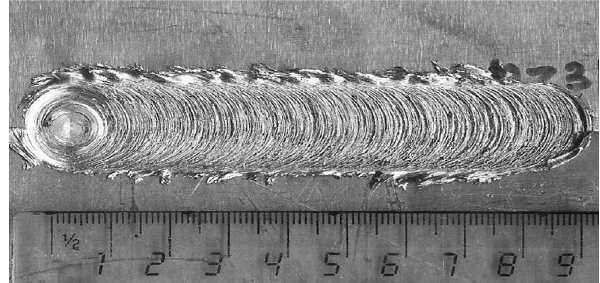
Figure 1: Weld coupon obtained at the parameters 300 rev min − 1 to 400 rev min − 1 , 50 mm min − 1 optimized welding speed; scale in cms.